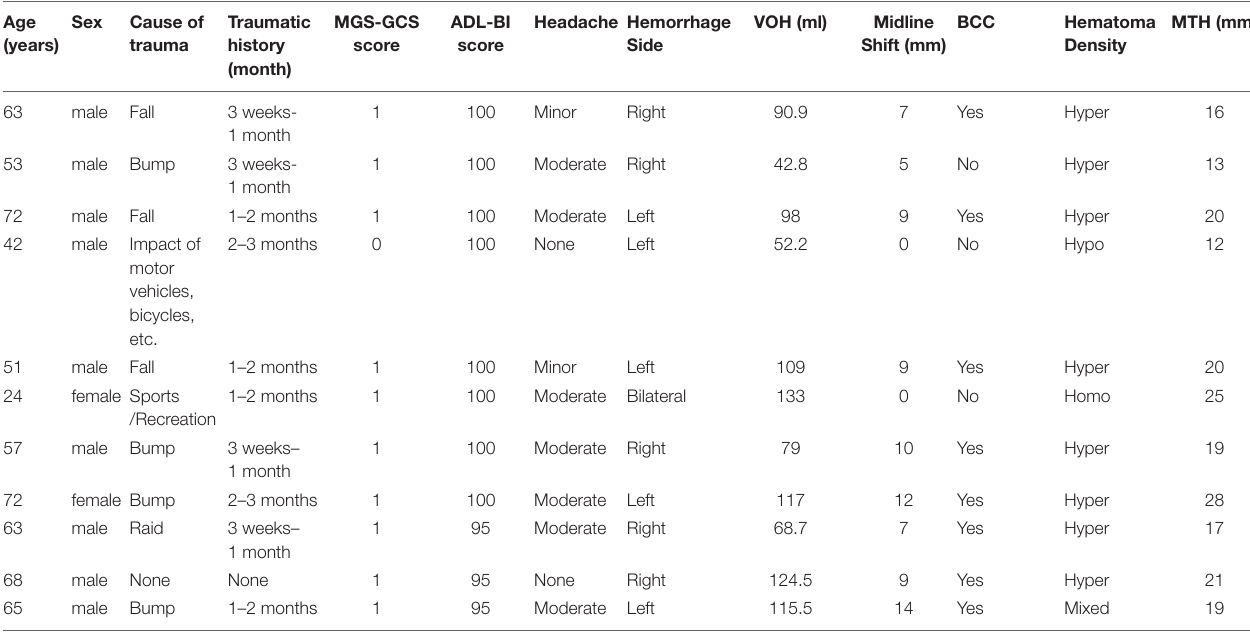
TABLE 4 | Demographic information of patients who were switched to